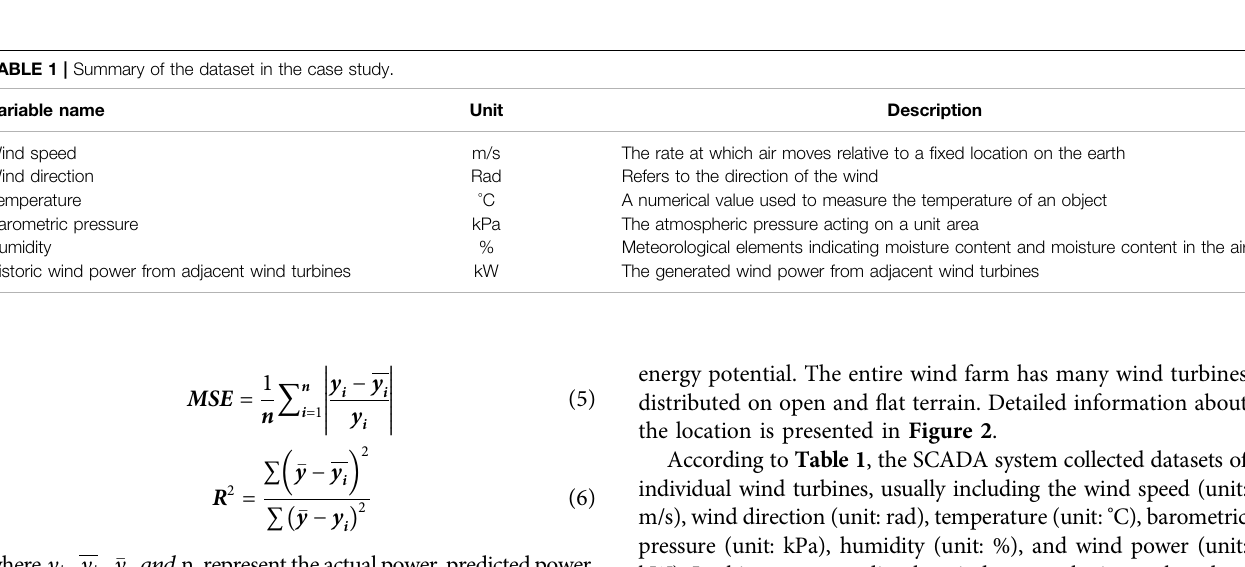
FIGURE 2 | Location of the case study wind farm in Hami County, Xinjiang, China.